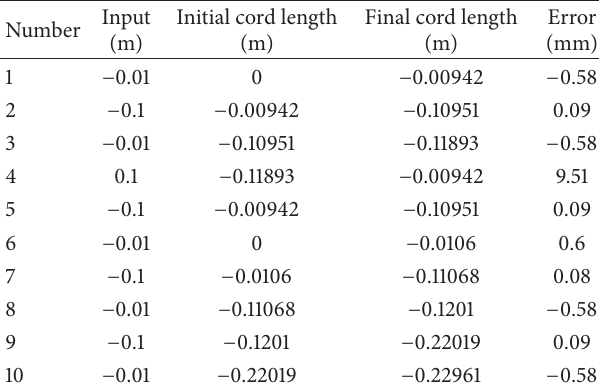
Table 2: Feedback values of stroke